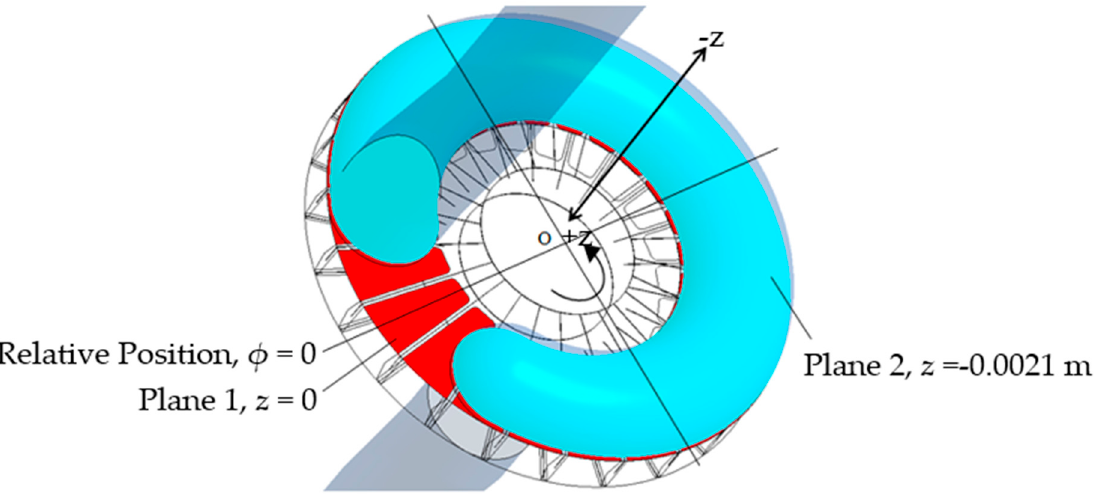
Figure 7. Axial planes view.